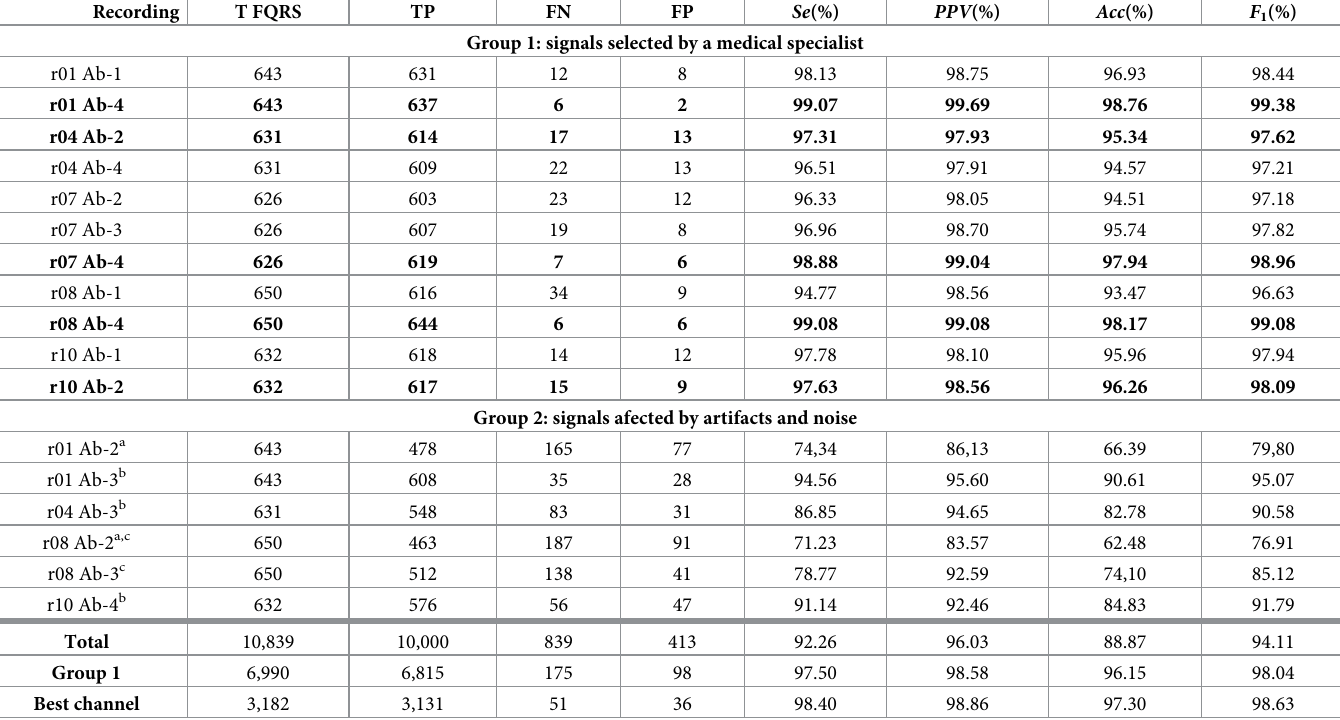
Table 1. Evaluation results using Abdominal and DirectFetal ECG Database 5-minute recordings as training data (data for the best performing channel in each recording are shown in bold